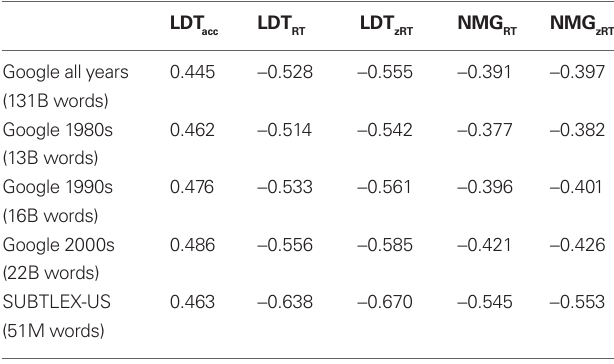
Table 1 | Correlations of the Elexicon data with word frequencies estimated on the basis of the Google American English Books Corpus and with SUBTLEX-US word